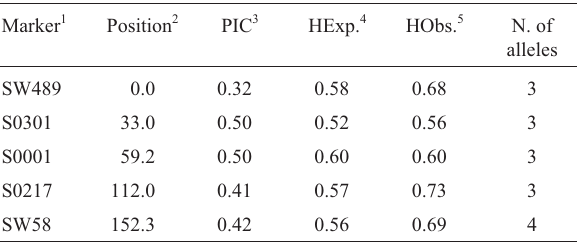
Table 1 - Microsatellite markers used for the mapping of pig chromo- some